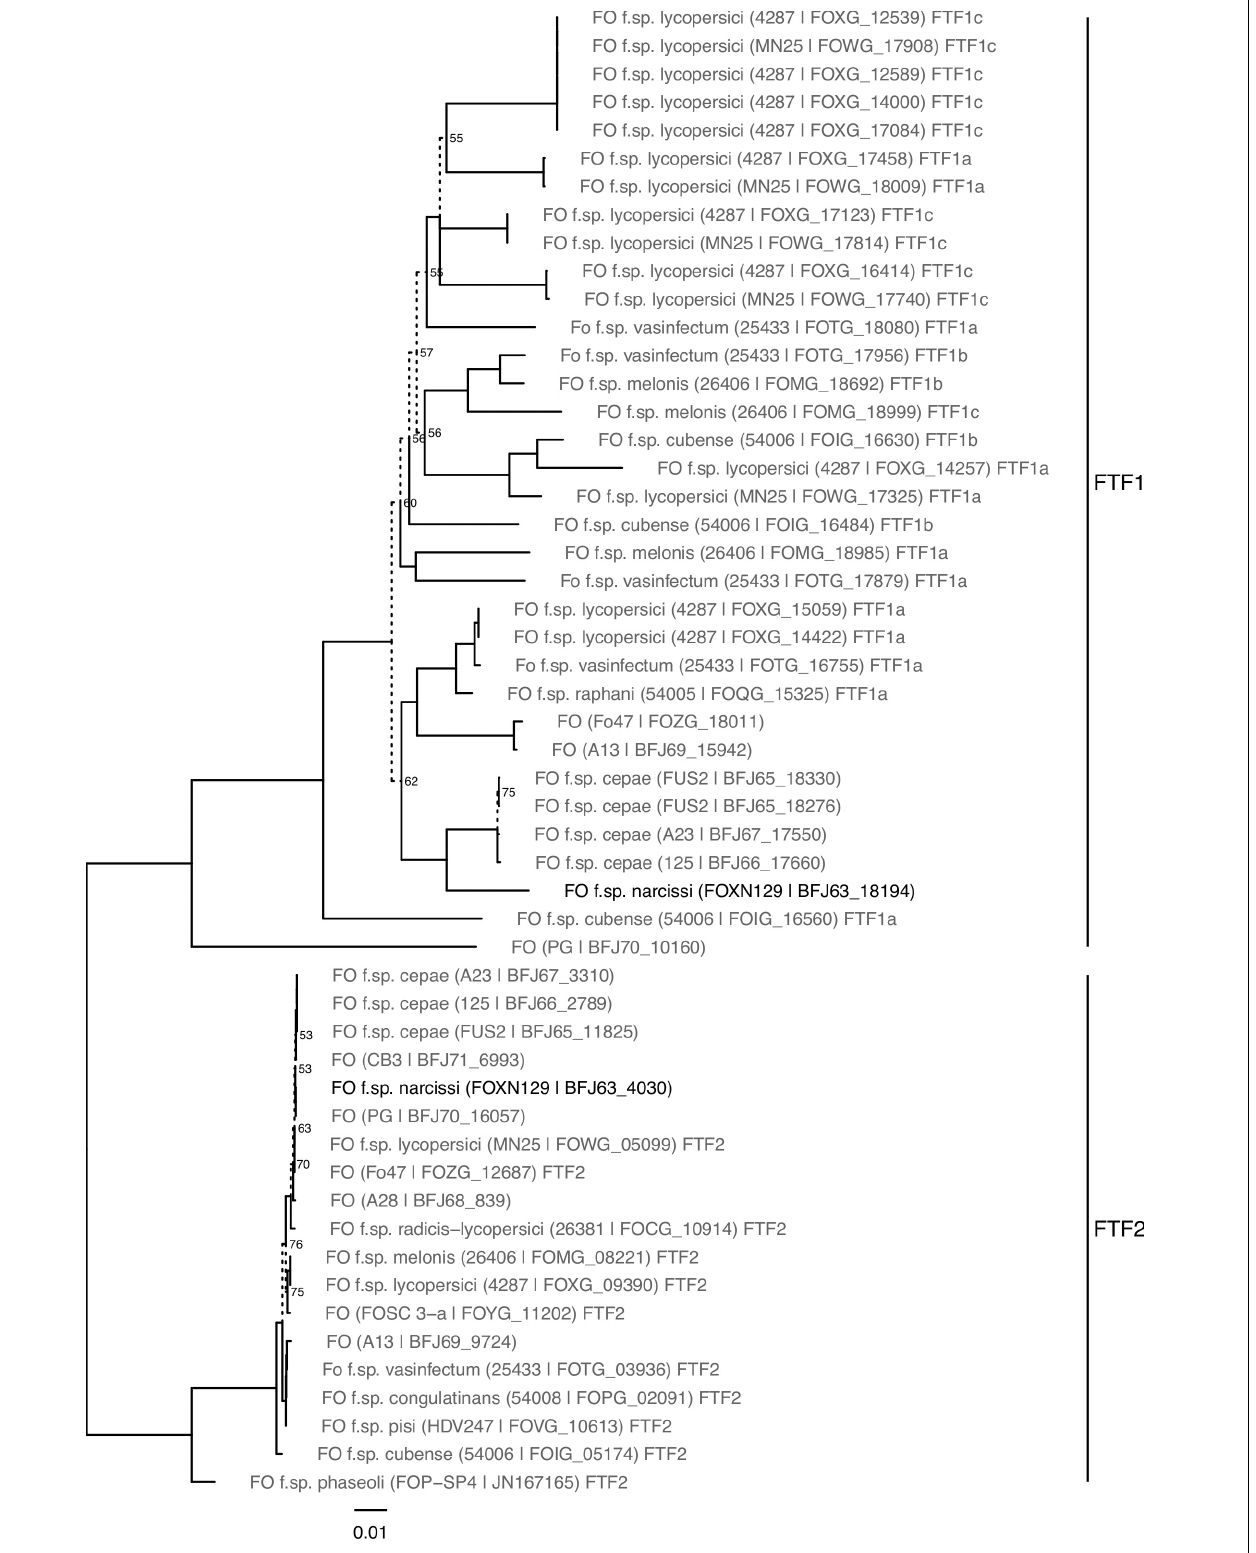
Frontiers in Microbiology |